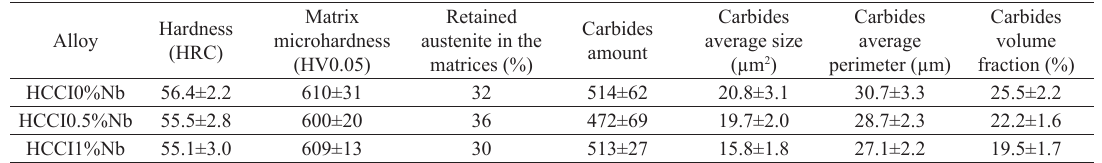
Table 4. Properties and microstructural quantifications of the